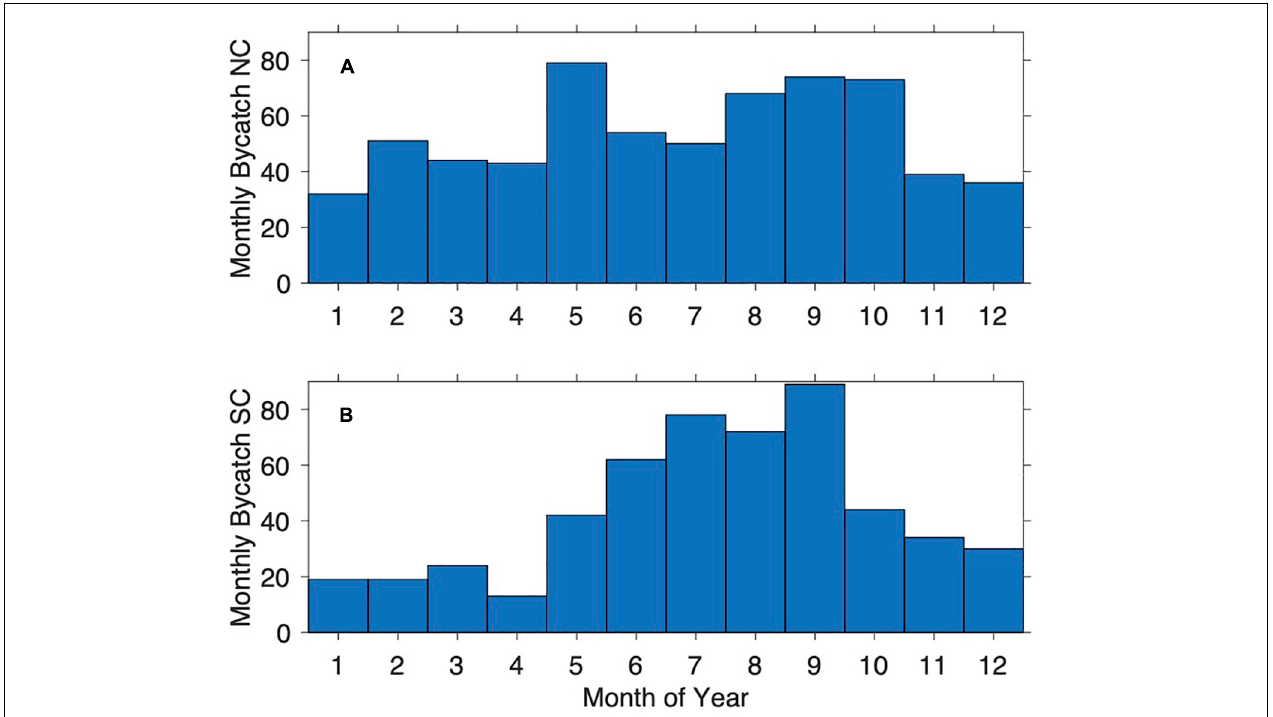
FIGURE 5 | Monthly catch of T. aduncus calculated as totals across the entire period (1980–2015) separated into the two areas North Coast (NC; A ) and South Coast (SC; B ).